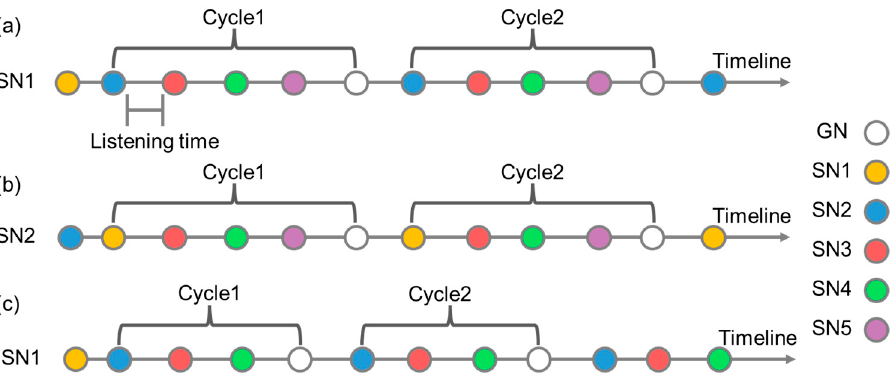
Figure 2. The process of forwarding message packets by the SN in order: ( a ) using SN1 as an example; ( b ) using SN2 as an example; ( c ) the process of forwarding message packets by the SN after dynamically adjusting and removing the failed SN5 (using SN1 as an example).